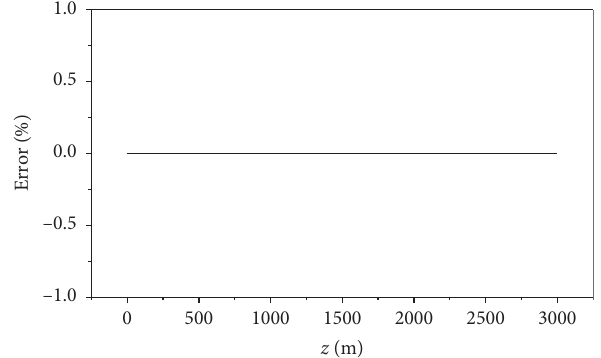
Figure 7: The relative error between approximate and accurate solutions while r �